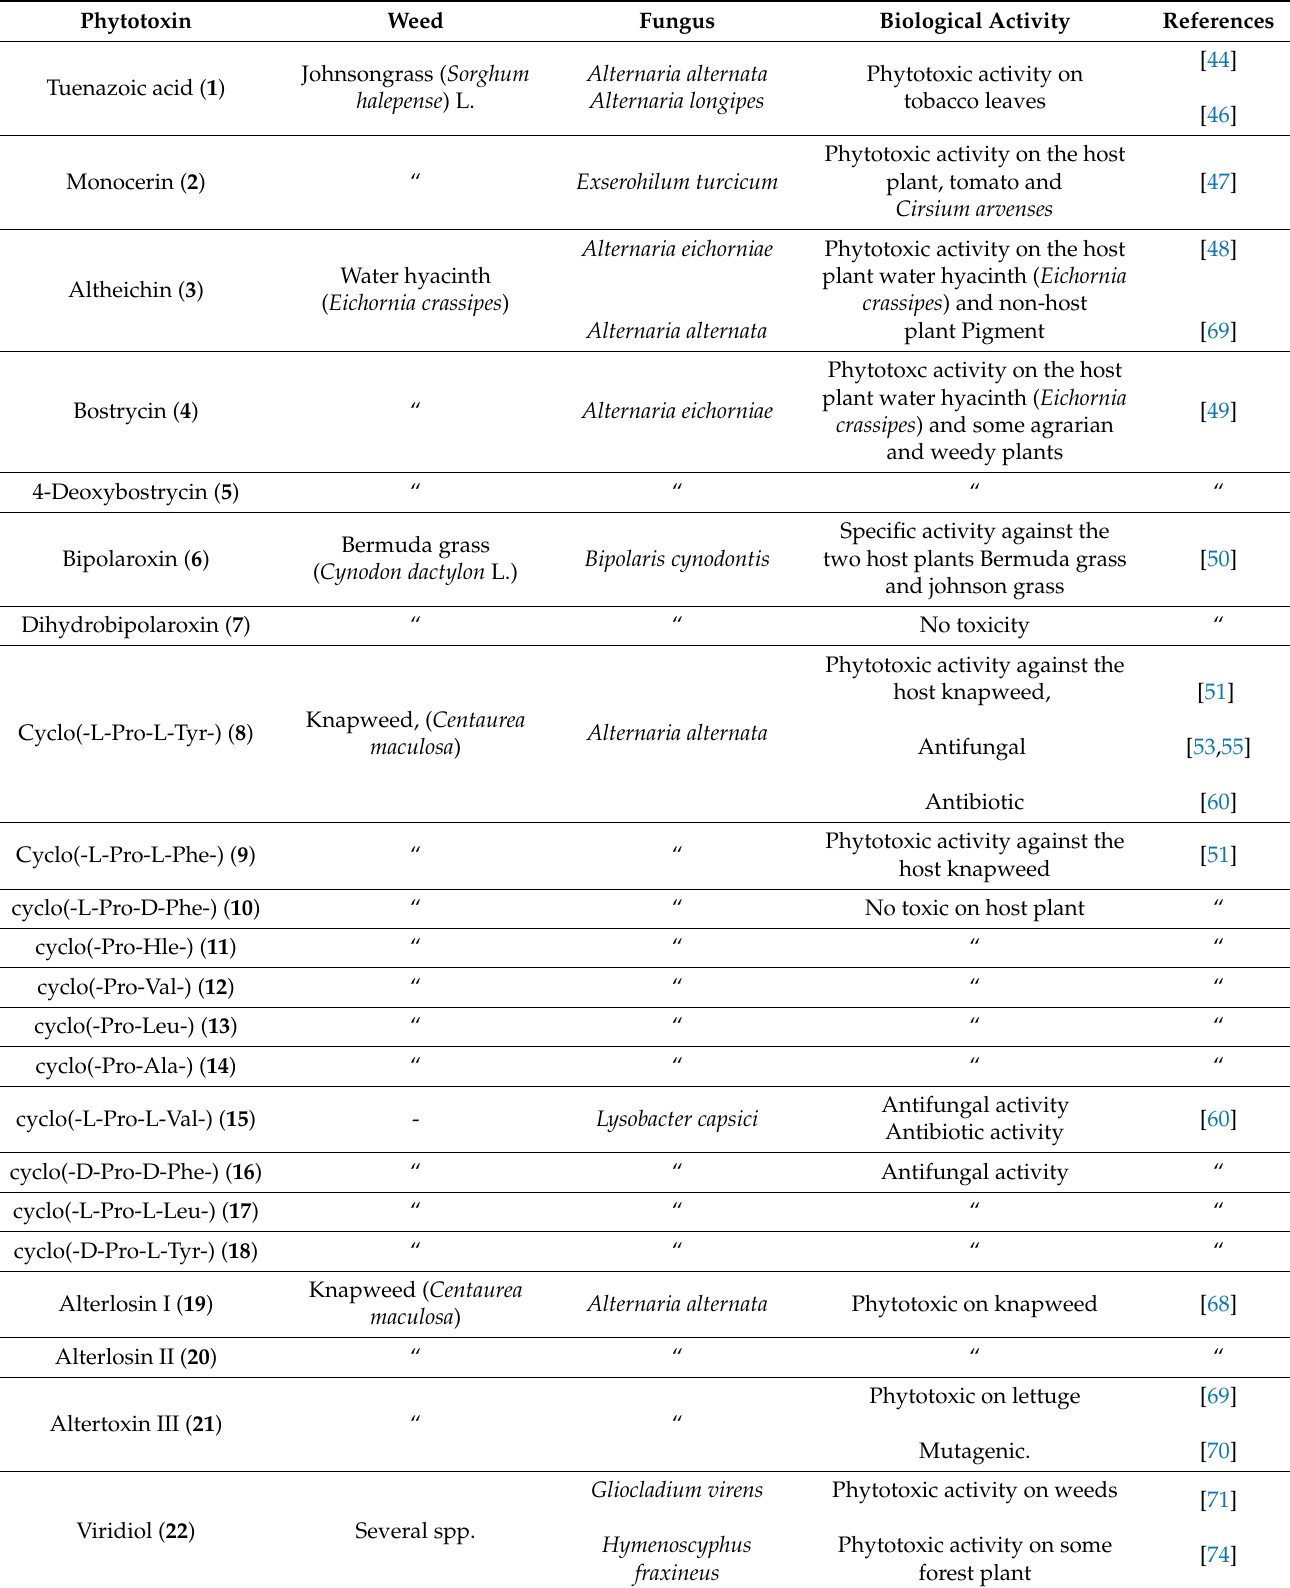
Table 2. Microbial phytotoxins to biocontrol